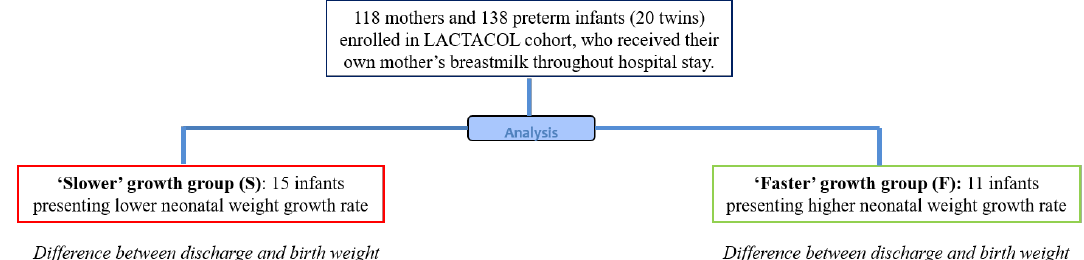
Figure 1. Study flowchart of infants enrolled in the ancillary study of the mono-centric prospective population-based LACTACOL (for global study flowchart of LACTACOL, see [20]). Among the 138 infants included in the LACTACOL cohort, no infant presented necrotizing enterocolitis (NEC), 4 infants had retinopathy of prematurity (ROP) of light severity, 3 presented intraventricular hemorrhage (IVH) of grade 2, 8 displayed bronchopulmonary dysplasia (BPD) at 28 days and 6 at 36 weeks’ postmenstrual age. The 26 selected infants did not have NEC, ROP, or BPD.